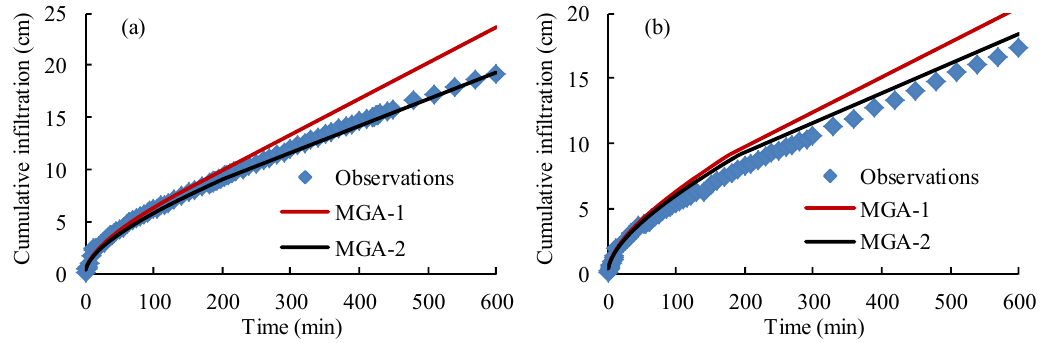
Figure 10. Comparison of the observed wetting front advancement and the calculated value with the modified Green-Ampt models for cases ( a ) L1S1L1, ( b ) L1S2L1, and ( c ) L1S3L1 in Experiment I.